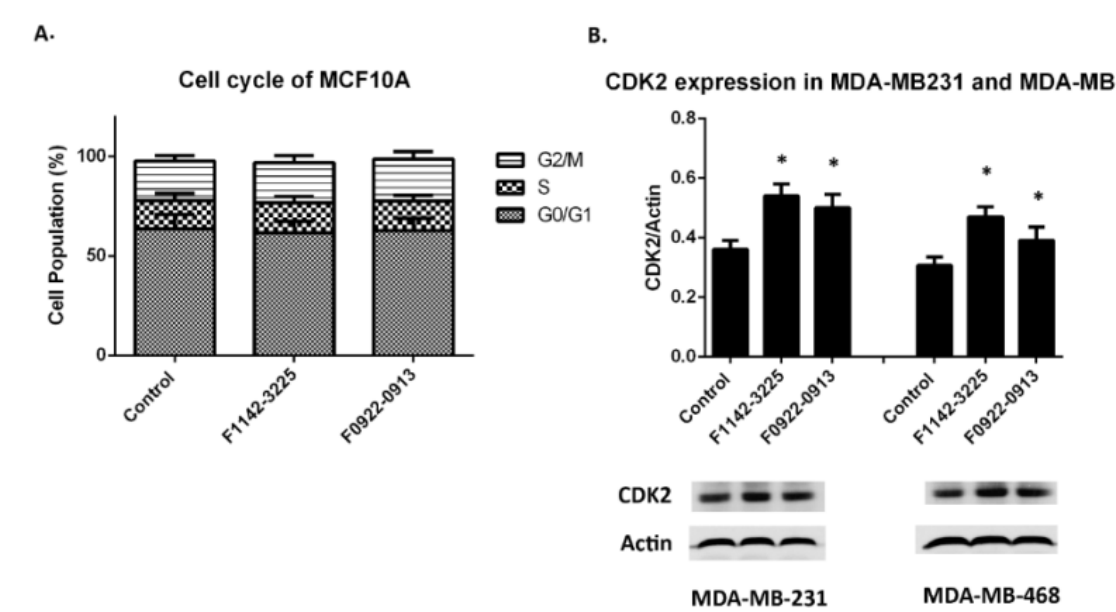
Figure 3. The cell cycle distribution of MCF10A cells and CDK2 protein expression in TNBC cell lines. ( A ) Cell cycle distribution in response to F1142-3225 or F0922-0913 in MCF10A cells. Data are presented as % of living cells (G0/G1, S, and G2/M cells = 100%). Each value represents the mean of experiments, carried out in triplicate (mean ± SD). Statistical significance was determined by one-way ANOVA. ( B ) CDK2 protein expression after treatment with F1142-3225 or F0922-0913, for 48 h, was determined by western blot in MDA-MB-231 and MDA-MB-468 cells. Data are reported as the mean ± SD ( n = 3) of the individual experiments. Statistical significance was determined by Student’s test: * p < 0.05 vs. control (ctrl). Detailed information about Western Blot can be found at supplemen- tary materials.